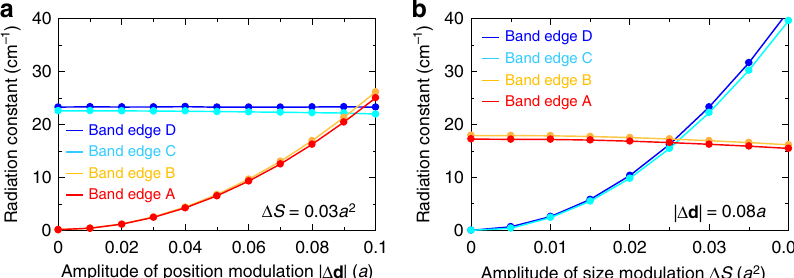
Fig. 3 Calculated radiation constants for dually modulated photonic crystals by a three-dimensional coupled wave theory. a Radiation constants of band-edges A – D with respect to the amplitude of position modulation j Δ d j , where the amplitude of size modulation Δ S is fi xed to 0 : 03 a 2 . b Radiation constants with respect to the amplitude of size modulation Δ S , where the amplitude of position modulation j Δ d j is fi xed to 0.08 a . Throughout these calculations, the polar emission angle θ and azimuthal emission angle ϕ are fi xed to 36 (cid:4) and 0 (cid:4) = 180 (cid:4) ,